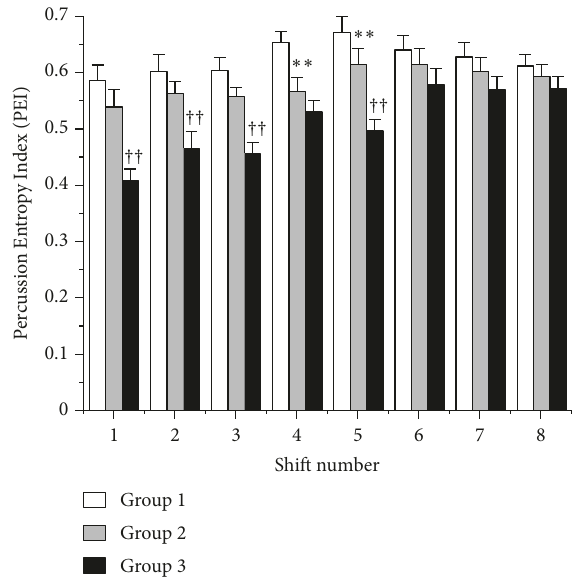
Figure 3: Changes in percussion entropy index of the three groups of testing subjects from shift number (s) of 1 to 8; ∗∗ p < 0.001: Group 1 vs. Group 2; †† p < 0.001: Group 2 vs. Group 3; Group 1: healthy subjects; Group 2: diabetic subjects with satisfactory blood sugar control; Group 3: diabetic subjects with poor blood sugar control. Values are expressed as mean ±